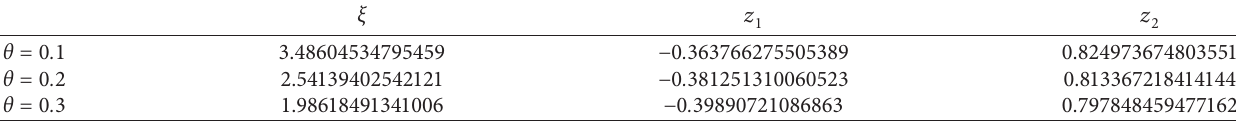
p � 0 . 6, p � 0 . 7, θ � 0 . 3, and v � 0 . i and ξ for 0